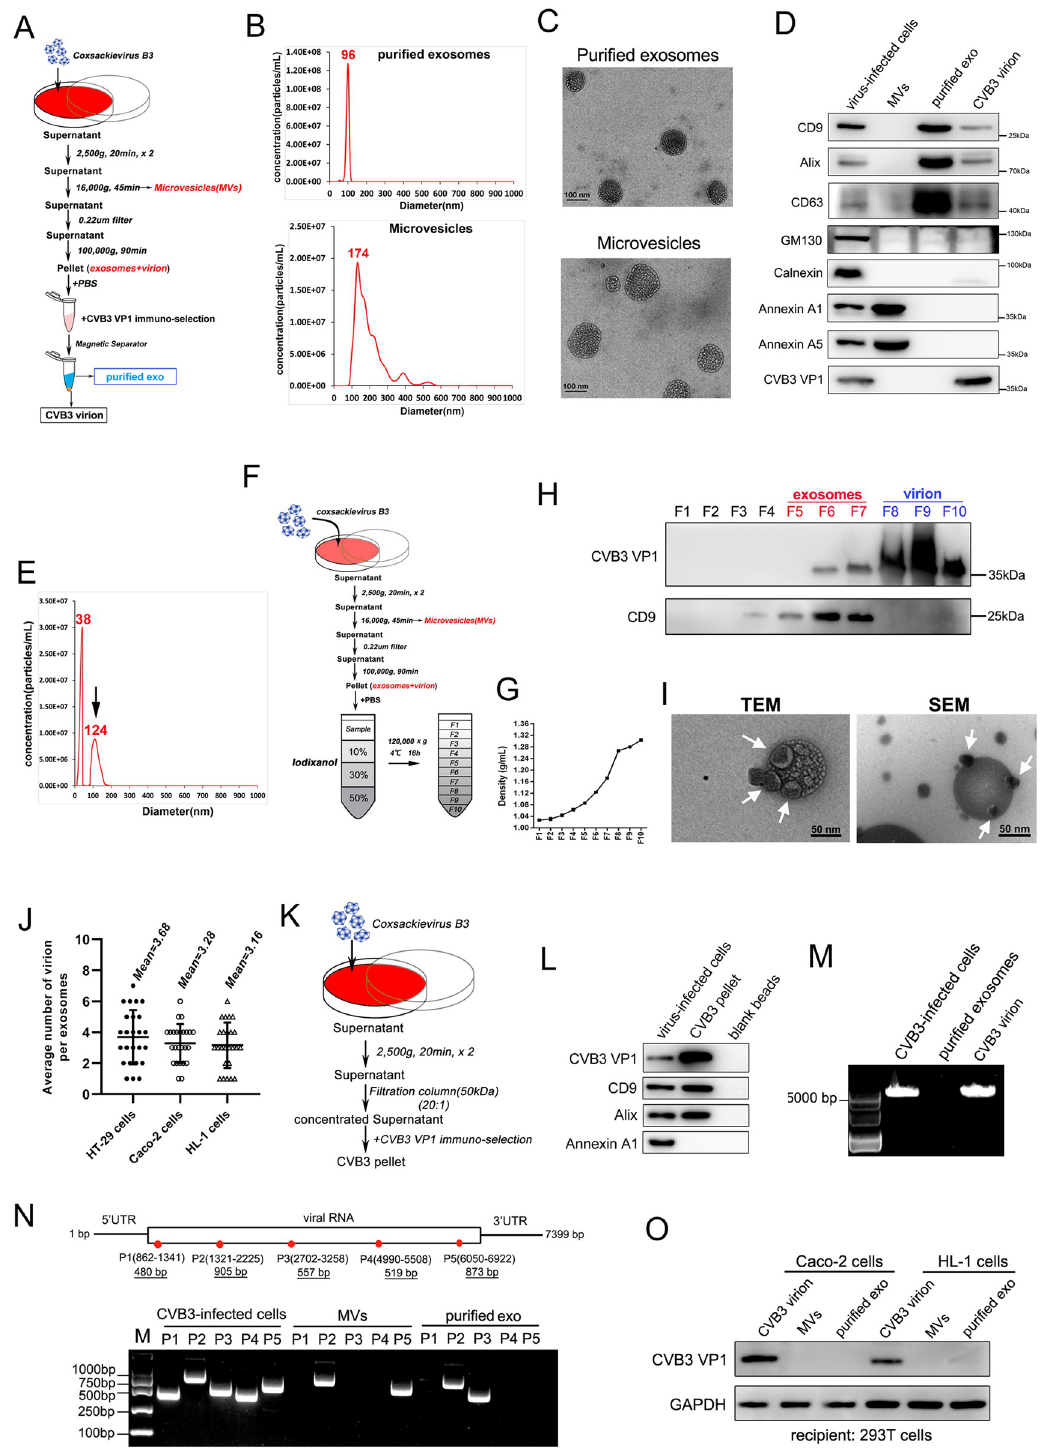
Fig 3. Exosomes as carrier vehicles for CVB3 virions. (A) Schematic presentation of immuno-magnetic isolation method to separate microvesicles(MVs) virion and exosomes from CVB3-infected Caco-2 cells. Caco-2 cells were infected with CVB3 at a 0.05 TCID 50 for 1h, then the cells were washed and switched to medium supplemented with EV-depleted FBS for the production of MVs, exosomes and virus particles. (B and C) The purified exosomes and MVs were analyzed by Nanoparticle Tracking Analysis(NTA)(B) and transmission electron microscopy(C). (D) Purified exosomes, MVs and CVB3 virion derived from